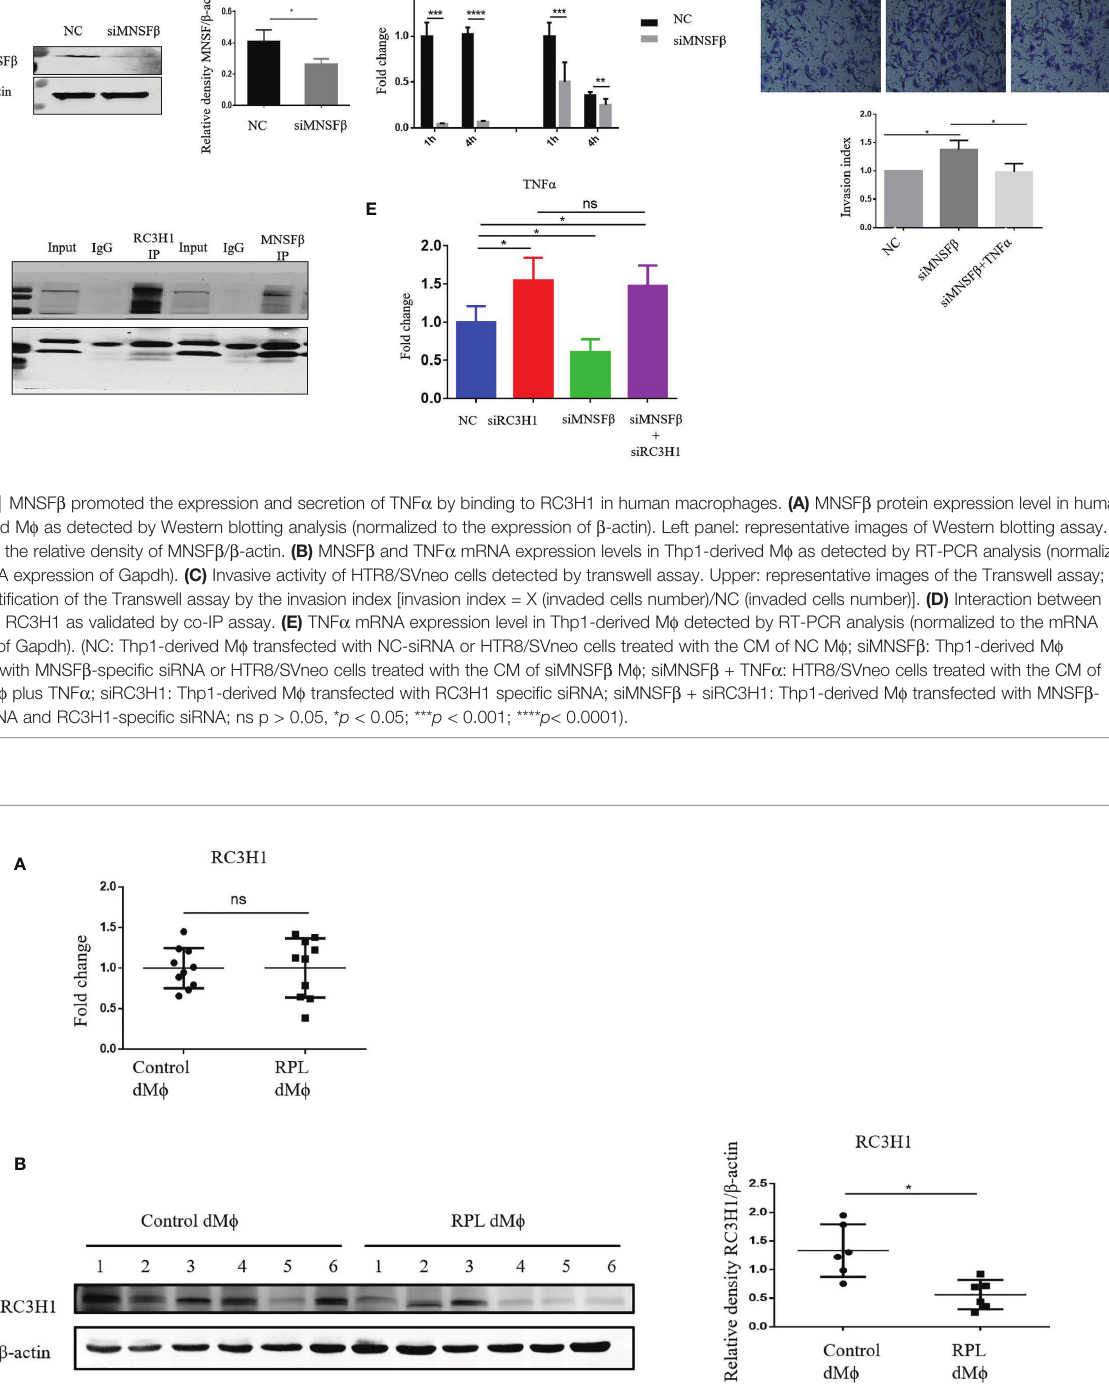
FIGURE 6 | Changes in the RC3H1 protein expression level of dM f from RPL patients. (A) RC3H1 mRNA expression level in dM f from Control women ( n = 10) and RPL patients ( n = 10) as detected by RT-PCR analysis (normalized to the mRNA expression of Gapdh). (B) RC3H1 protein expression level in dM f from Control women ( n = 6) and RPL patients ( n = 6) as detected by Western blotting analysis (normalized to the expression of b -actin). Left panel: representative images of Western blotting assay; right panel: the relative density of RC3H1/ b -actin. (Control dM f : dM f isolated from decidual tissues from normal women in early pregnancy; RPL dM f : dM f isolated from decidual tissues of RPL patients, ns p > 0.05, * p <